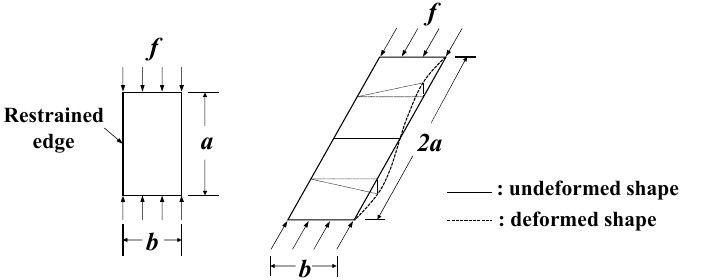
Figure 5. Outstanding flange under edge compression.